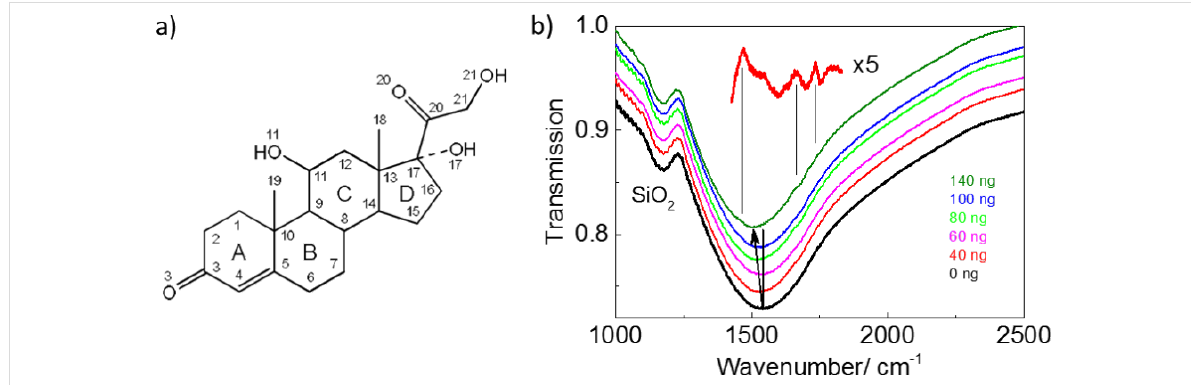
Figure 5: (a) The cortisol chemical structure and numeration of atoms in the cortisol molecule. (b) IR spectrum of a bare Au nanoantenna array and cortisol deposited from the solution with concentration 10ng/µL on the array. Inset shows the detailed fragmentary IR spectrum of 40 ng of cortisol after subtraction of the envelope